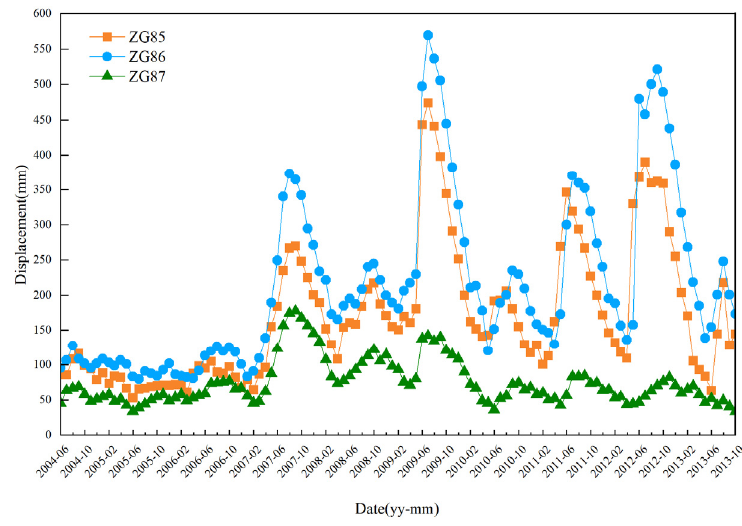
Figure 6. Extracted value of the PTD of each monitoring station. Table 1. Correlation of displacement change at different times with the PTD of each monitoring station.